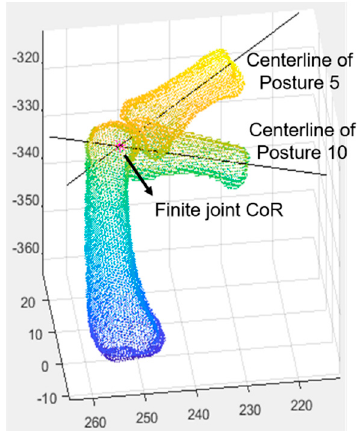
Figure 8. Determination of the finite finger joint center of rotation (CoR) between two postures by the intersection of the centerlines of the distal bone surfaces of the two postures.